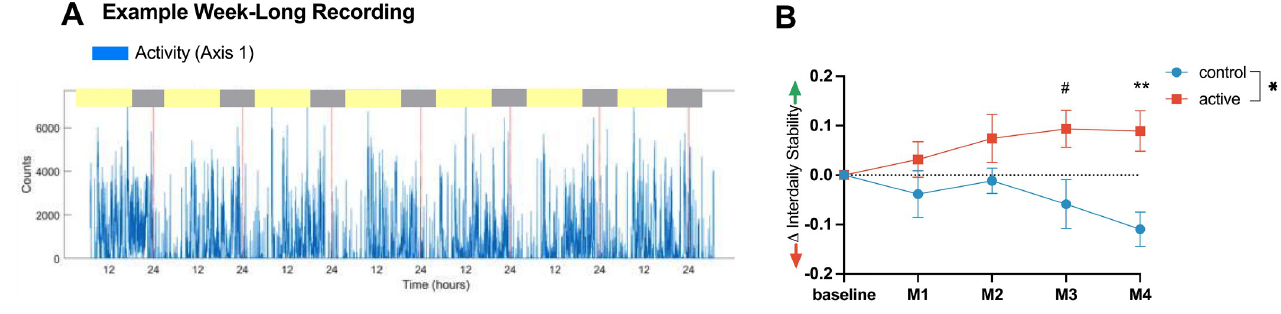
Fig 5. Changes in rest-activity patterns relative to baseline. (A) Example 7-day activity recording of activity counts (blue) with red dotted lines every 24 hours from an individual. Inter-daily Stability (IS) quantifies the regularity of day-to-day rest-activity patterns. (B) Improved IS compared to baseline (means ± SEM) in active group (red) but not control group (blue), with significant differences between active and control groups at Month 4 ( �� p < 0.01) and a trend at Month 3 (#p < 0.1). Statistical analysis with a 2-Way ANOVA with Sˇı´da´k’s multiple comparisons at each monthly timepoint. Mean of control = -0.055, mean of active = 0.072. Main effect of intervention p = 0.037, interaction of intervention x time, p = 0.025. Multiple comparison at Month 3, p = 0.051, Month 4, p = 0.007.